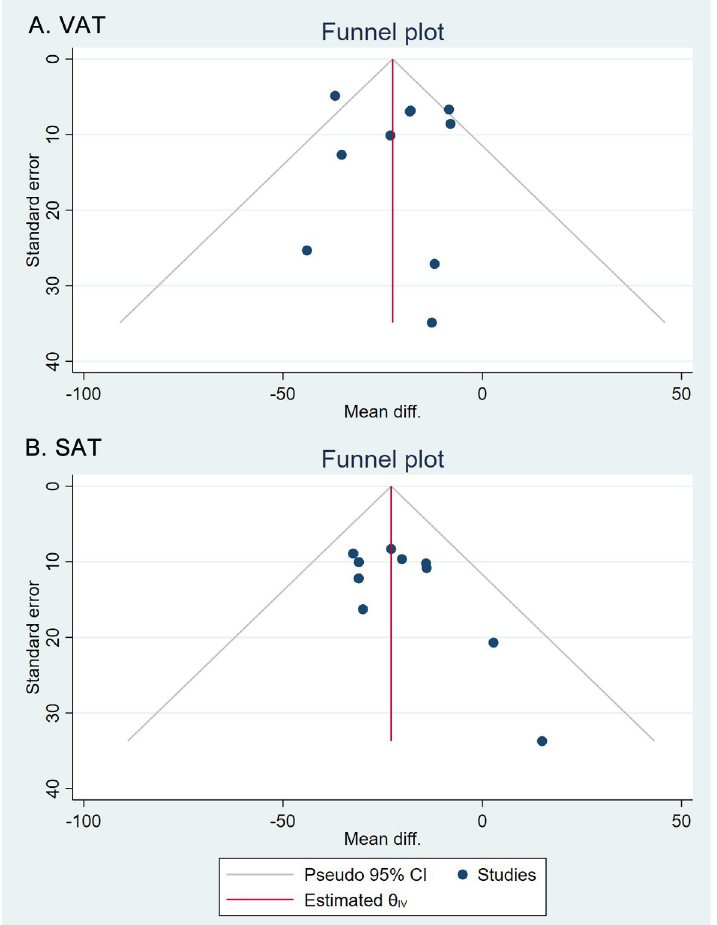
Fig 3. Begg’s funnel plots for publication bias of VAT and